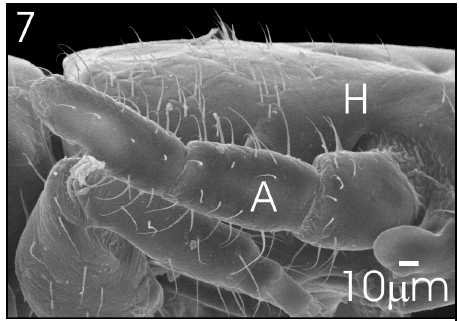
Fig. 7. The three segments of each of the antennae (A).